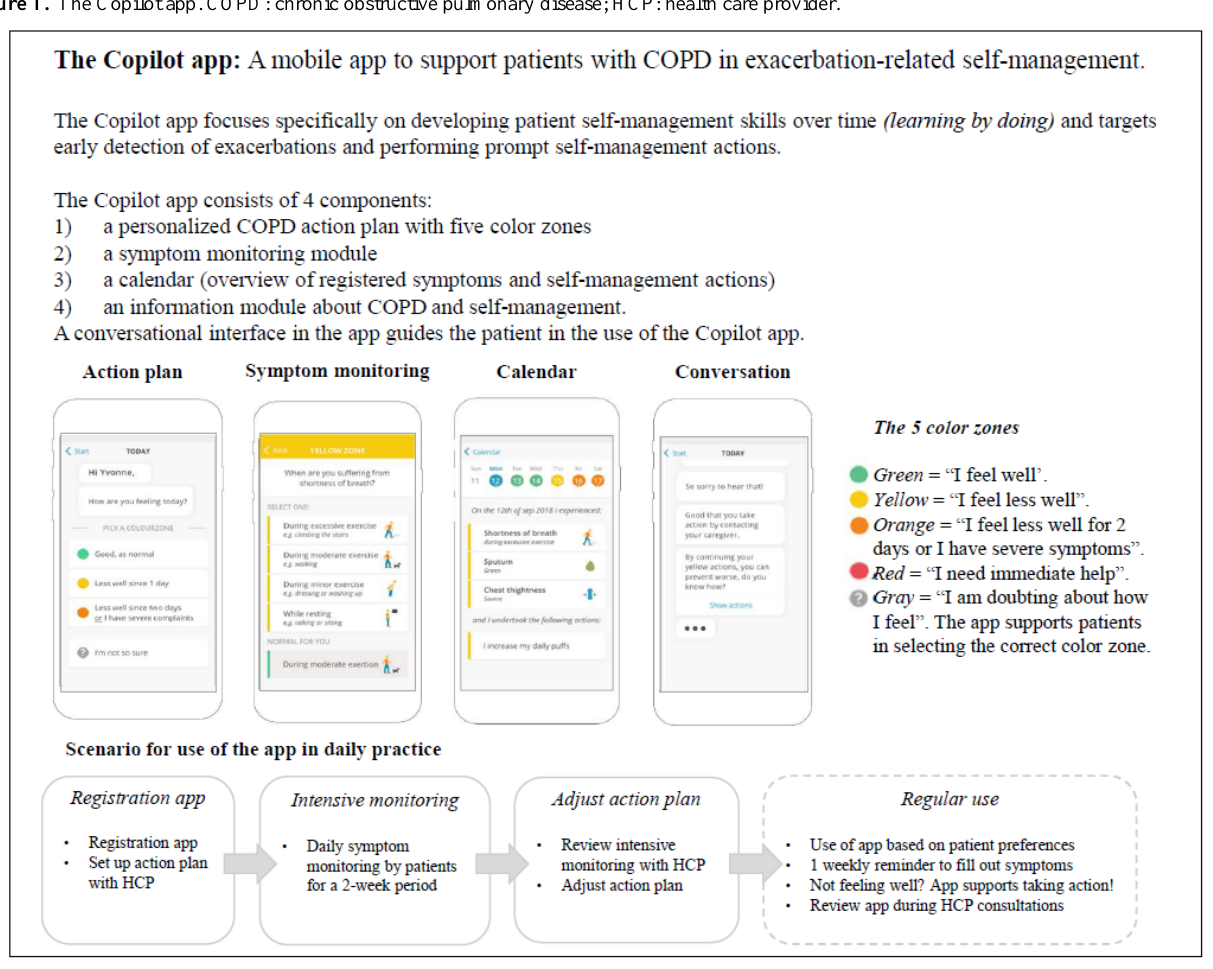
Figure 1. The Copilot app. COPD: chronic obstructive pulmonary disease; HCP: health care